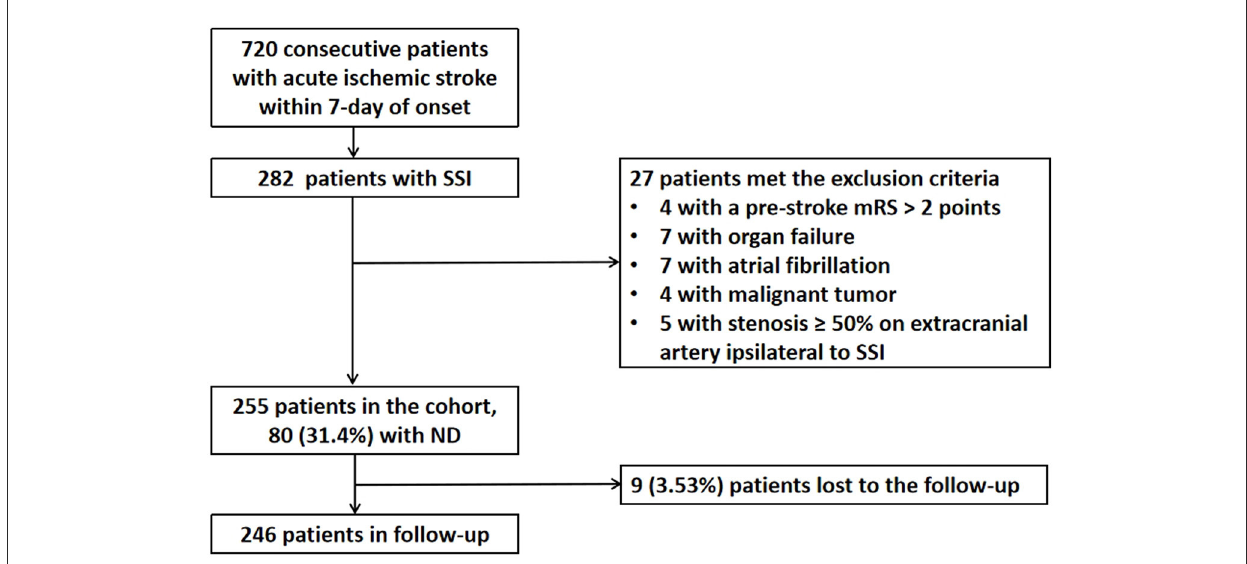
FIGURE3 Flowchart of patient enrollment and follow-up. SSI, single subcortical infarction; ND, neurological deterioration; mRS, modified Rankin